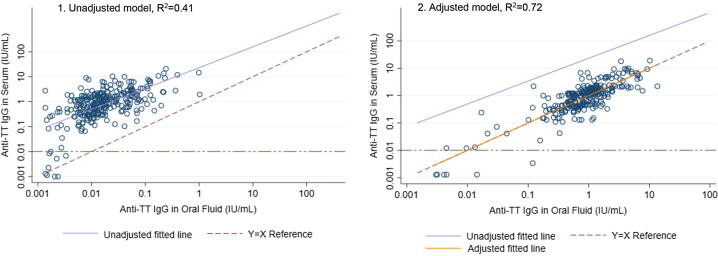
Comparison of unadjusted and predicted fit with interaction model of anti-TT IgG in oral fluid and serum. Note: Panel 1 depicts the unadjusted values of anti-TT IgG in oral fluid vs. serum as dark blue points and unadjusted fitted line in blue, compared to the Y = X reference line, represented as a red dashed line. Panel 2 depicts the same unadjusted fitted line and the adjusted values and fitted line in solid orange after adjustment with interaction model. The equation for the adjusted model was: Anti-TT IgG in Serum = α + β(anti-TT IgG in OF) + β(Total IgG in OF) + β(anti-TT IgG in OF*Total IgG in OF) + β(OF Volume) + β(Pentavalent Doses). Green horizontal line at 0.01 IU/mL represents cutoff of serological protection for the assay. (For interpretation of the references to color in this figure legend, the reader is referred to the web version of this article.)